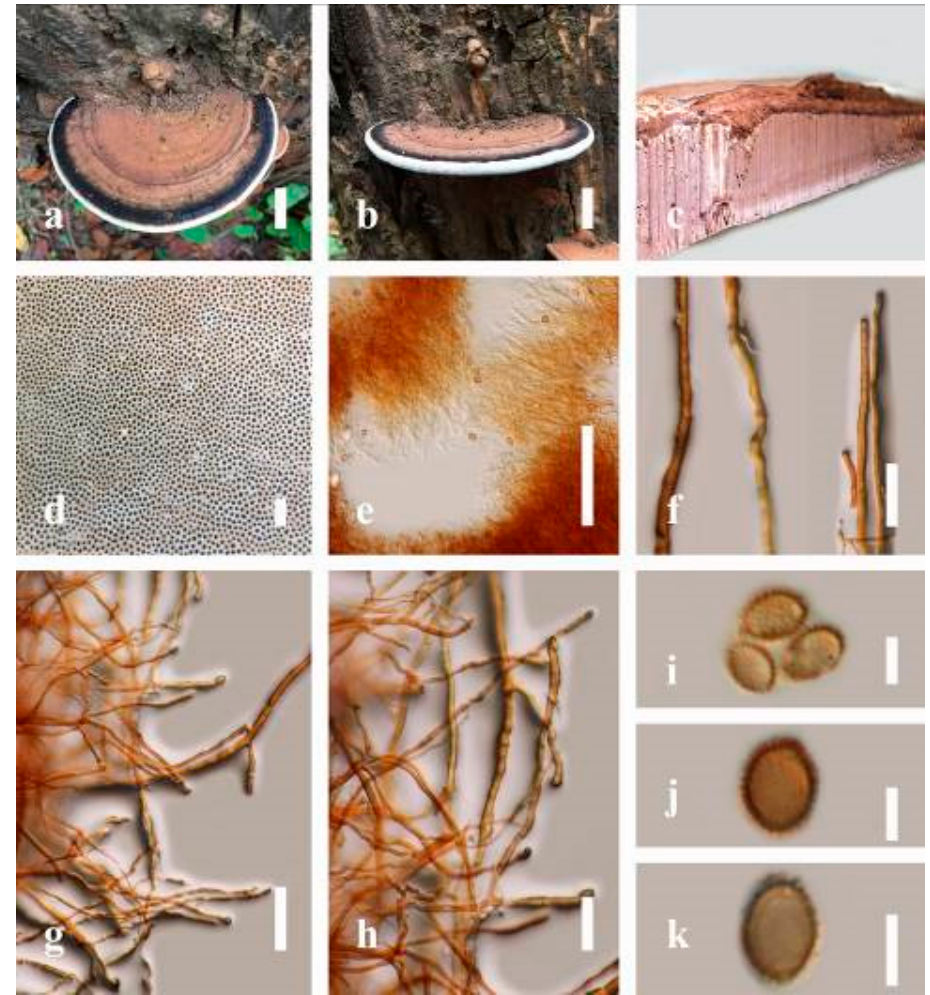
Figure 23. Morphology of Ganoderma applantum (MFLU 19-2175): ( a , b ) mature basidiomes; ( c ) section of the basidiomes; ( d ) pore characteristics; ( e ) hyphae of pore layers; ( f ) generative hyphae of context in Melzer’s reagent; ( g , h ) thick-walled with sparing branched of generative and skeletal hyphae of context in Melzer’s reagent; ( i – k ) basidiospores in Melzer’s reagent. Scale bars: ( a , b ) = 2 cm, ( d ) = 50 μ m, ( e ) = 150 μ m, ( f ) = 10 μ m, ( g ) = 30 μ m, ( h ) = 20 μ m, ( i – k ) = 5 μ m.